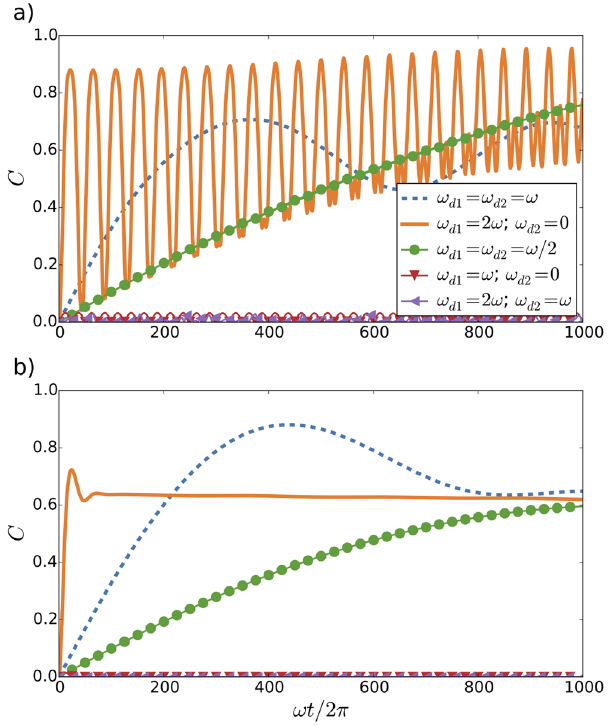
Figure 2. Concurrence C of two qubits initially located in the centre of the resonator and oscillating from mirror to mirror with frequencies ω d 1 and ω d 2 , respectively. For coupling constants g 1 = g 2 = g = 0.02, initial state , qubit decay parameter Γ = 0.002, and T 2 / T 1 = 0.67, we consider two cavity decay rates: ( a ) κ = 0.002, and g g 0 1 2 ( b ) κ = 0.2 (bad-cavity limit), in units of ω . These numerical results correspond to a broader parameter range, not limited by the perturbative approximation gT < 1, which for this case of g = 0.02 breaks for ≈ 8 ω t /2 π